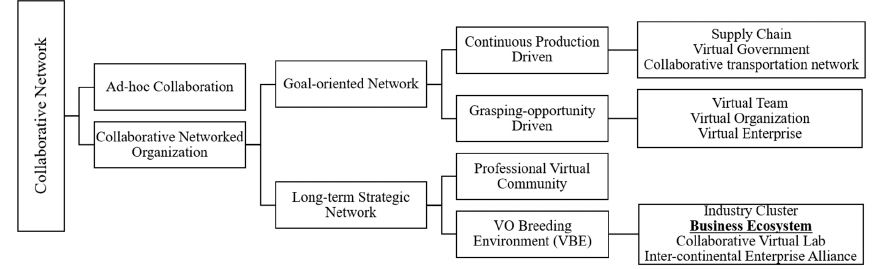
Figure 2. A Collaborative Networks’ Partial Taxonomy (based on [46]). Table 3. Motivations to Participate in a Virtual Organizations Breeding Environment